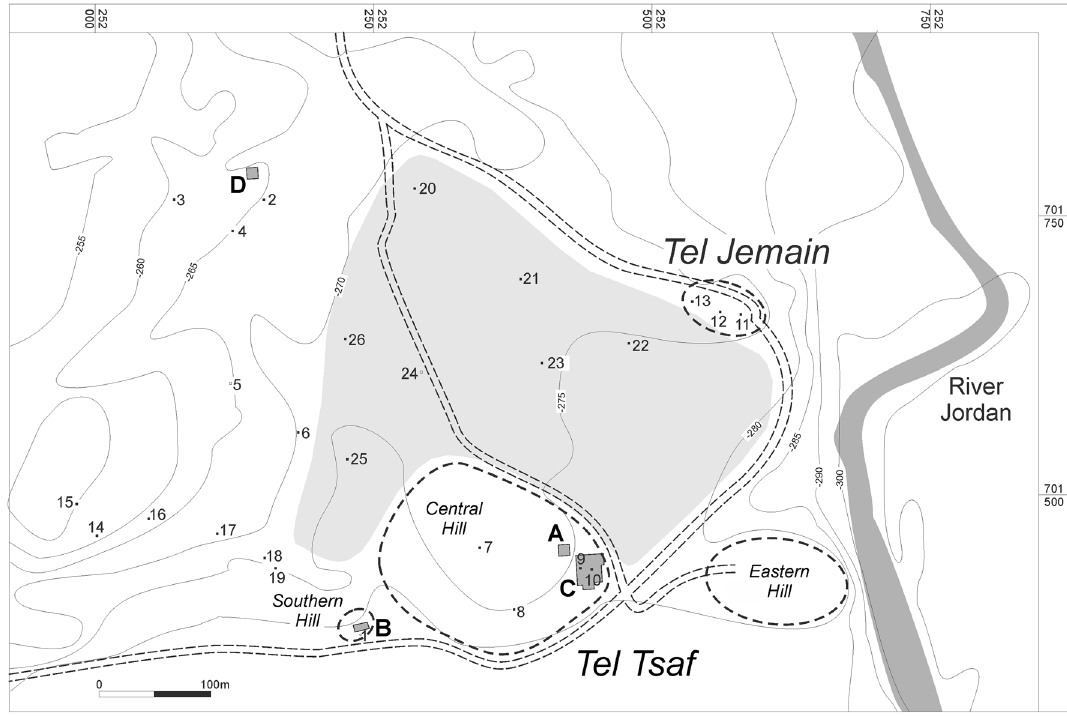
Figure 2. Map of Tel Tsaf and surroundings. Area C = settlement area, Area B = well. Gray area marks a recent cultivated area (Map by J. Rosenberg; taken from[ 32 :Fig.